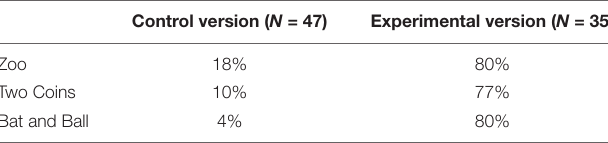
TABLE 3 | Percentages of correct